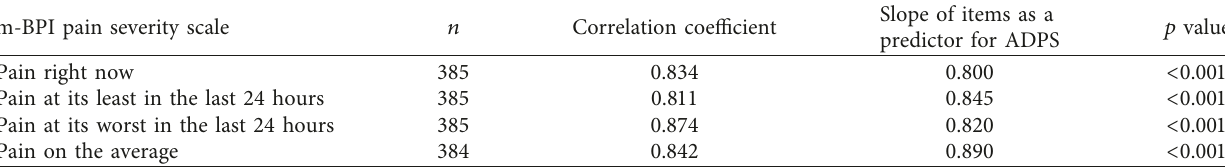
Table 2: Polyserial correlations and regression slopes of the m-BPI pain severity scale items with ADPS. m-BPI pain severity scale n Correlation coefficient